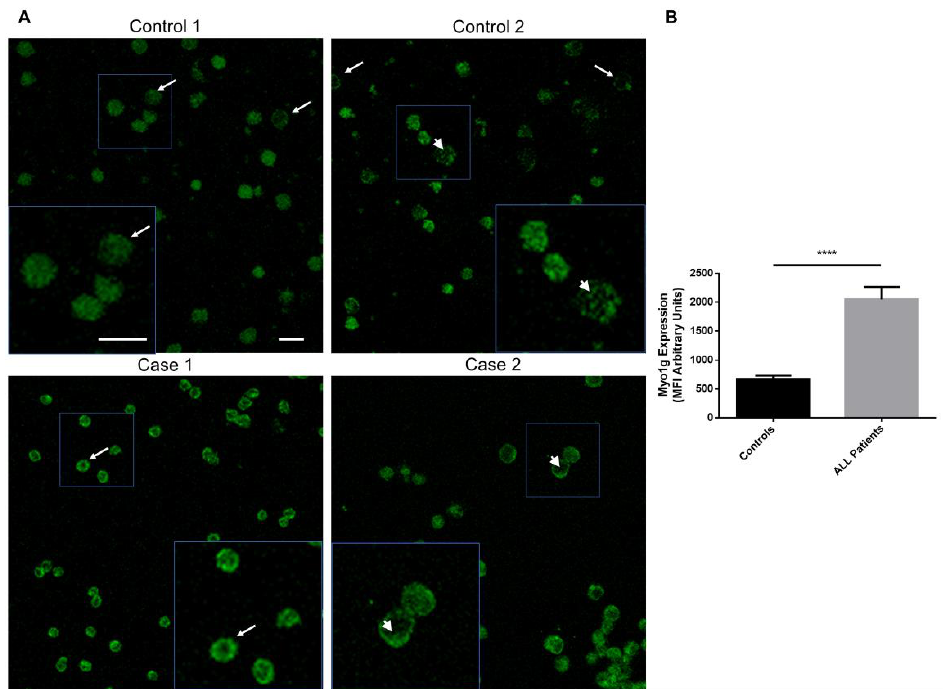
Figure 4. Myo1g detection in pediatric acute lymphoblastic leukemia patients. ( A ) Representative confocal images of the expression of Myo1g in two controls and two ALL patients. Arrows indicate Myo1g expression at the plasma membrane or membrane extensions; arrowheads indicate Myo1g expression inside the cells; scale bars = 10 µm. ( B ) Mean fluorescence intensity (MFI) of Myo1g expression in PBMCs from three controls and seven patients ( n = 71 control cells and n = 159 patient cells). **** p < 0.0001; two- tailed unpaired Student’s t -test; graph bars = 95% CI.